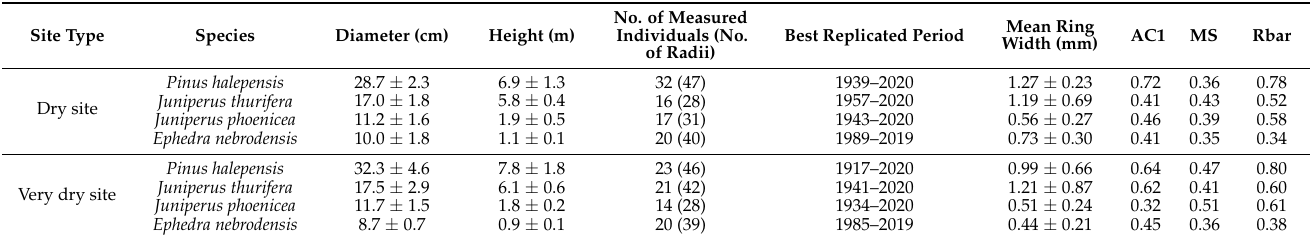
Table 2. Size and number of processed individuals and corresponding ring width statistics. Values are means ± standard deviations. Abbreviations: AC1, first-order autocorrelation; MS, mean sensitivity; Rbar, mean correlation between indexed ring-width series. The best replicated period was defined as that with an expressed population signal ≥ 0.85. Site